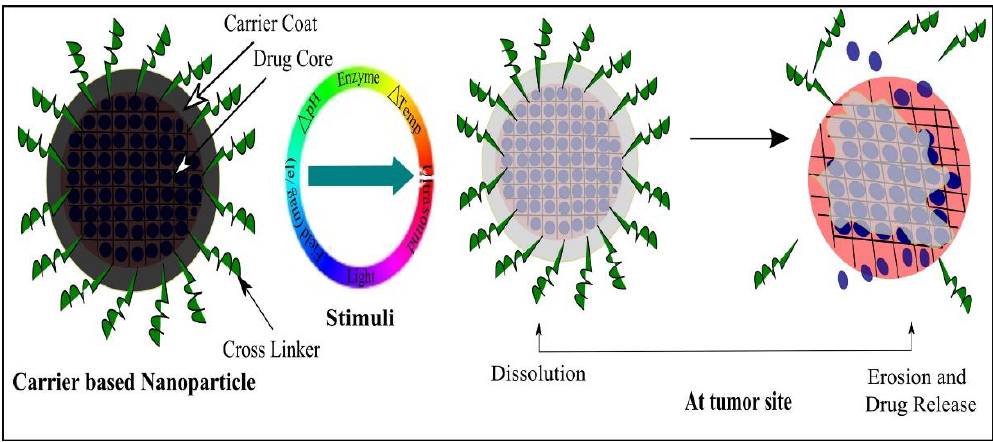
Figure 6. Stimuli-Responsive Carrier/Polymer-based Nanoparticle for Cancer Chemotherapy. Table 7. Stimuli-Responsive Carrier/Polymer-based Drug Delivery Systems for Cancer Chemotherapy.